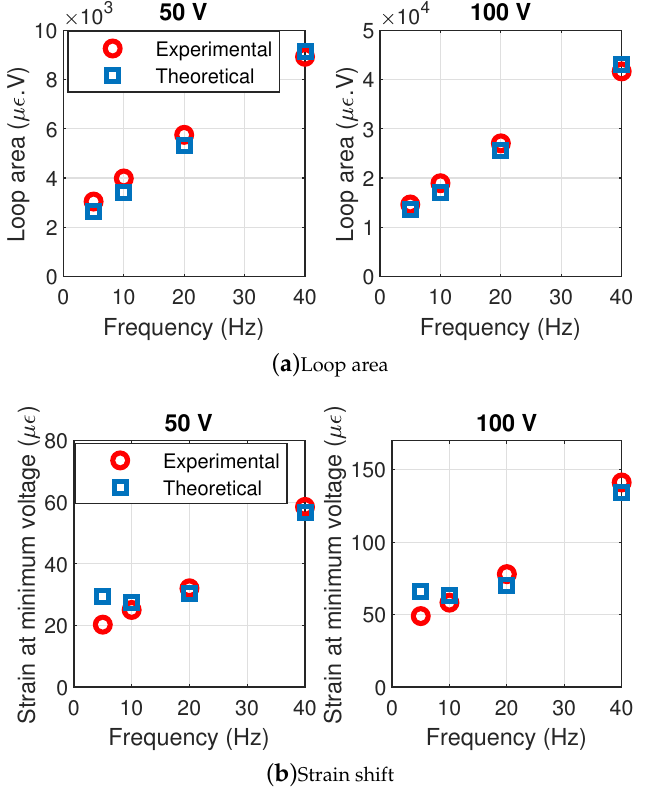
Figure 10. Experimental and predicted loop areas in steady state and strain